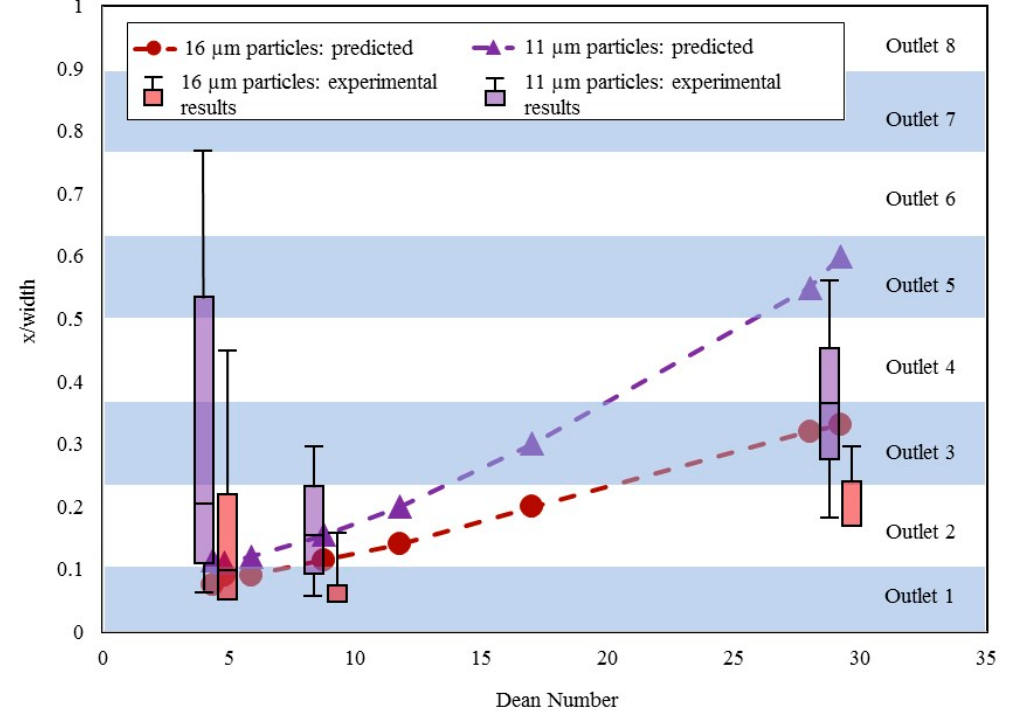
Figure 2. The predicted particle focusing behavior compared to experimental results of Design 1 for 11- and 16-µm particles [15,21,41]. The box-and-whisker results in this figure represent the median, 1st quartile, and 3rd quartile of the particle stream. The error bars include the 5th- and 95th-percentile of the particles with respect to the discrete outlet in which they were recovered.